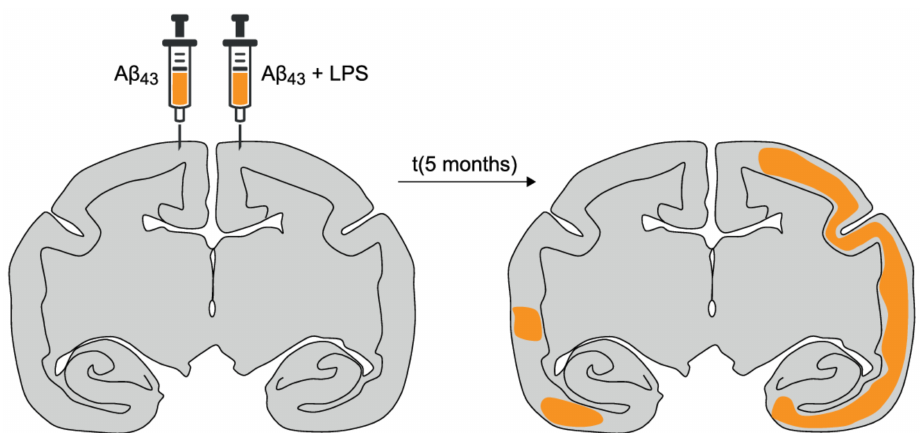
Figure 4. Plaque load and distribution in the brain of a marmoset monkey. The distribution of A β plaques measured five months after intracranial injection of A β with or without LPS (left) is visualized on a transcranial section (AP-0) and indicated in orange (right). The hemisphere in which A β 43 + LPS was injected showed significantly more severe amyloidopathy than the other hemisphere ( p < 0.001) [106]. Although the injection was given in the cortex 4 mm from the sutura sagittalis, the A β plaques were distributed over the temporal and posterior